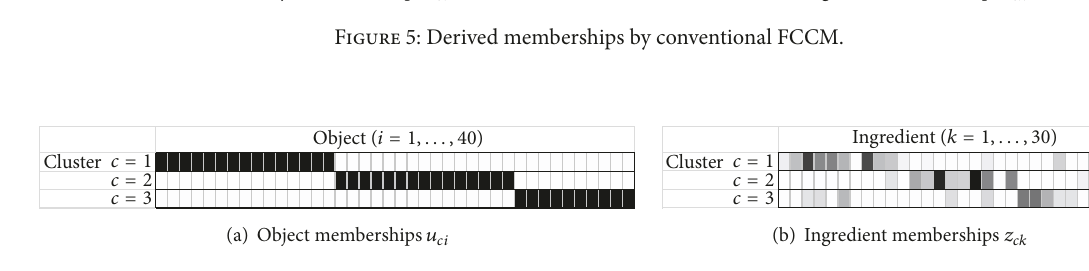
Figure 6: Derived memberships by conventional Fuzzy CoDoK.